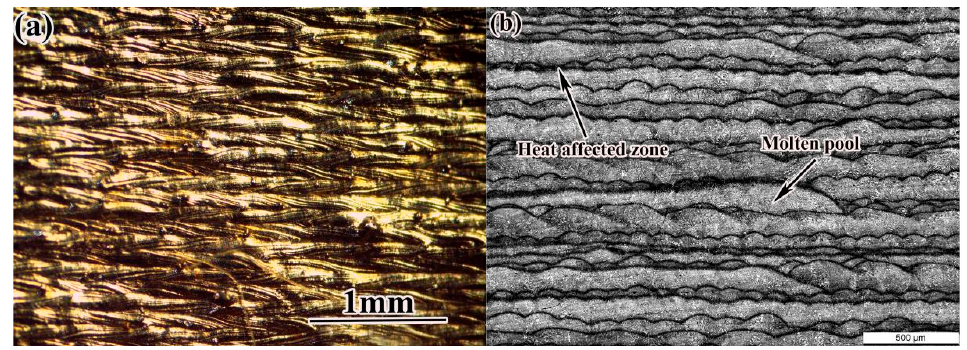
Figure 9. Surface morphology and microstructure of as-deposited sample: ( a ) surface morphology; ( b ) microstructure. ( b )